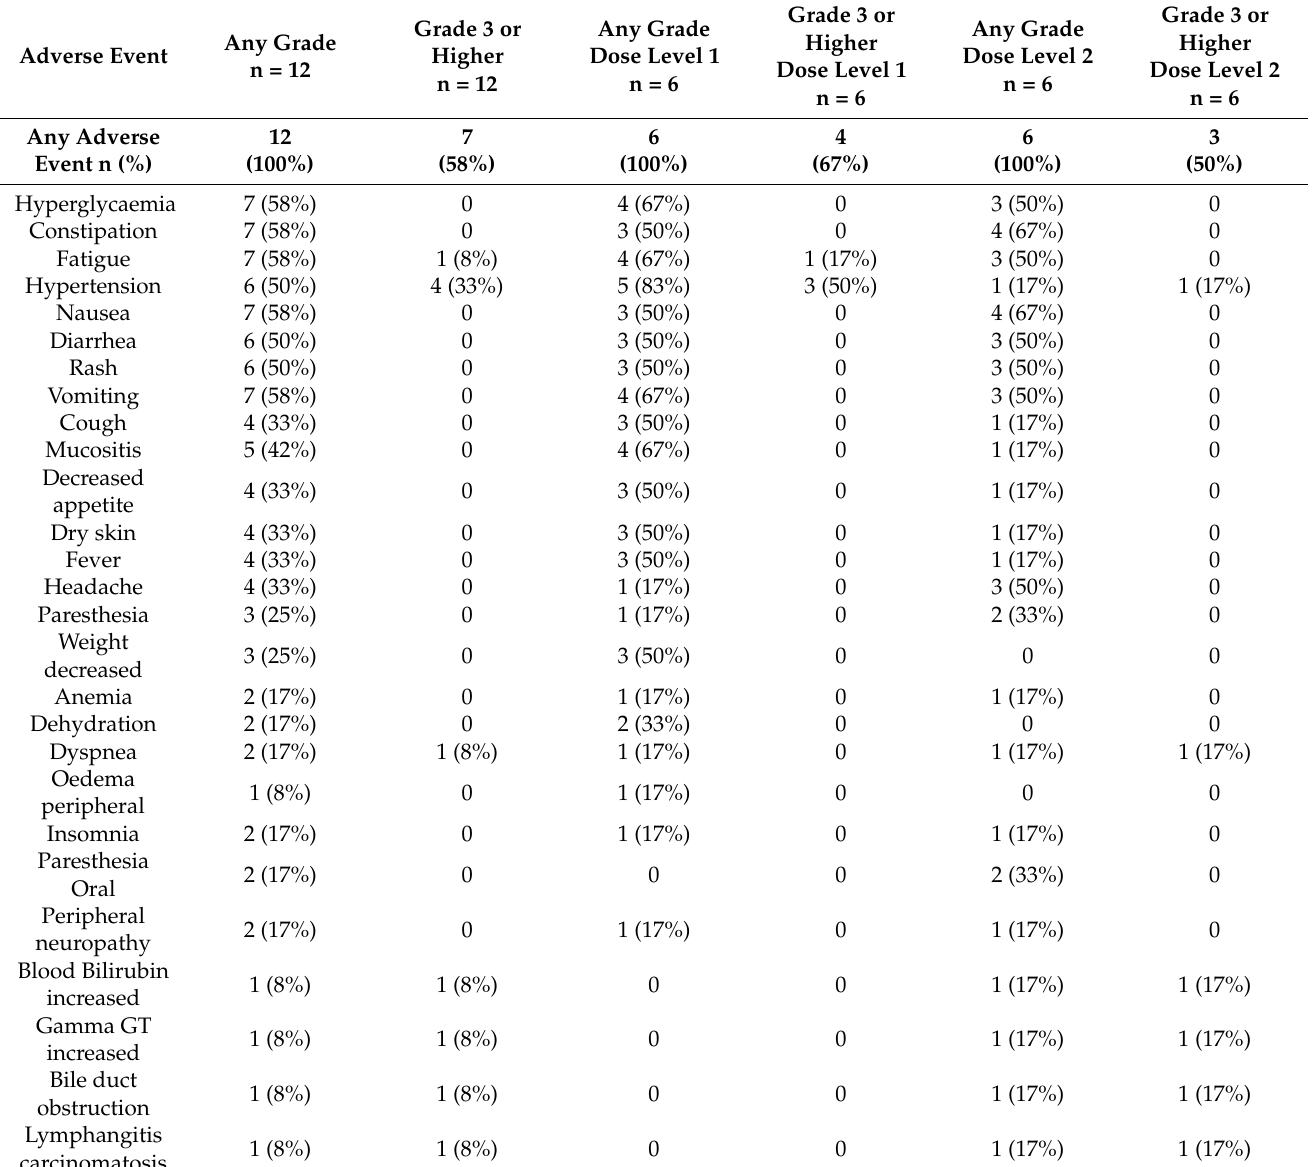
Table 2. All grade adverse events occurring in more than one patient regardless of attributed causality